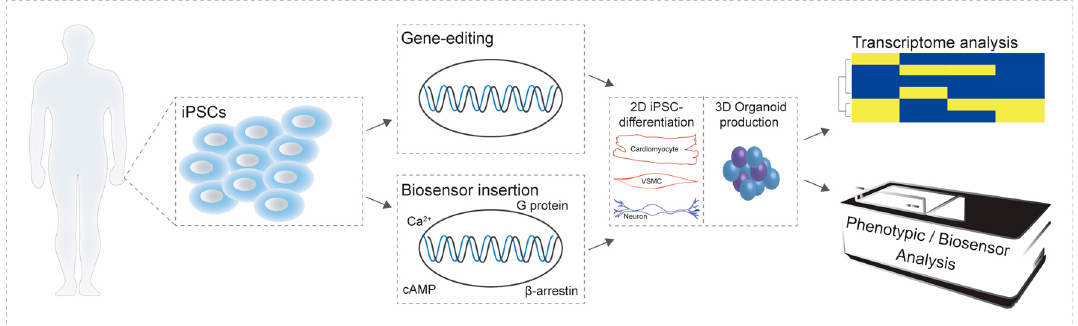
Figure 2. Schematic of biosensor applications within inducible pluripotent stem cells (iPSCs) and organoid models. Adult somatic cells from healthy or diseased individuals can be reprogrammed to generate iPSCs. The genome of the iPSCs can be edited to correct disease-causing mutations or to insert a biosensor via viral delivery or introduction in a safe harbor site. iPSCs can then be differentiated into desired cell-types or to generate organoid models of human disease (Figure 2). Extensive characterization of iPSCs is required, both at the genetic and functional levels, a necessary step for the validation of such models. Next, biosensor expression in iPSC-differentiated derivatives or organoids combined with imaging approaches will allow the characterization of cell signaling to better discern signal transduction events using physiological and disease-relevant cellular models.